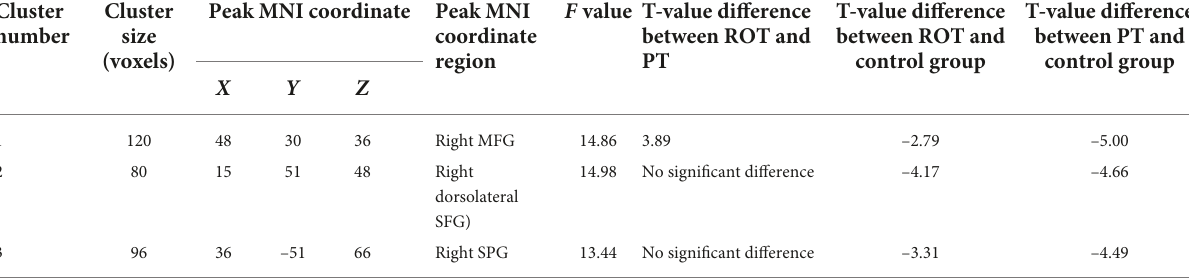
Table 3C Decreased activities in voxel-wise functional connectivity (ReHo cluster 1) for both ROT and PT groups than in the control